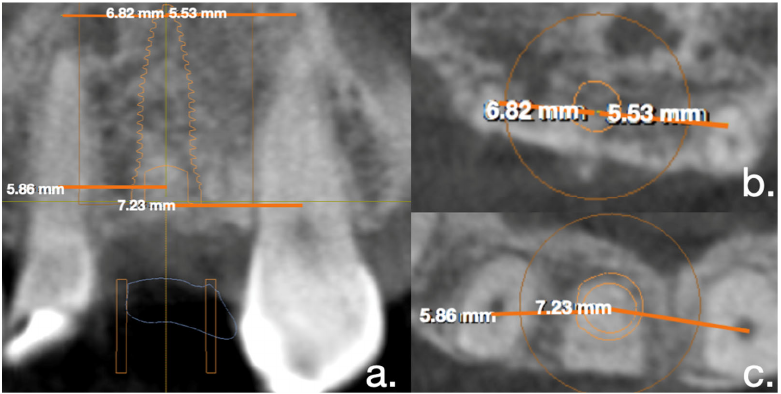
Figure 2. Comparison of mesiodistal deviation with adjacent teeth on CBCT scans performed before implant surgery to verify the congruence of implant placement. ( a ) Implant position in preoperative digital planning in coronal projection; ( b ) mesiodistal deviation of the implant with adjacent teeth at implant axis in axial projection; ( c ) mesiodistal deviation of the implant with adjacent teeth at implant head in axial projection.